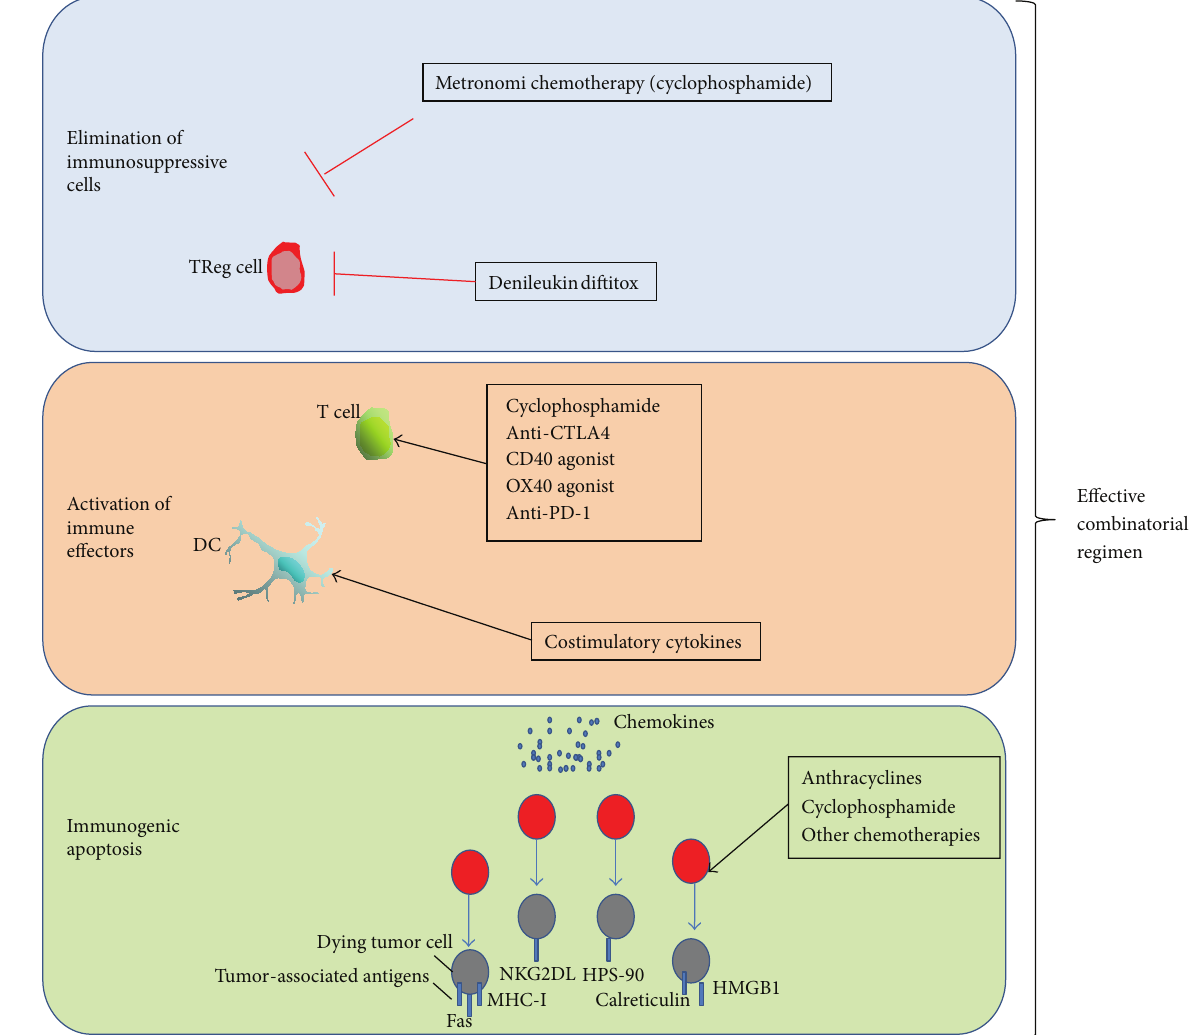
Figure 2: Mechanisms of action of conventional antineoplastic agents and new immunostimulatory